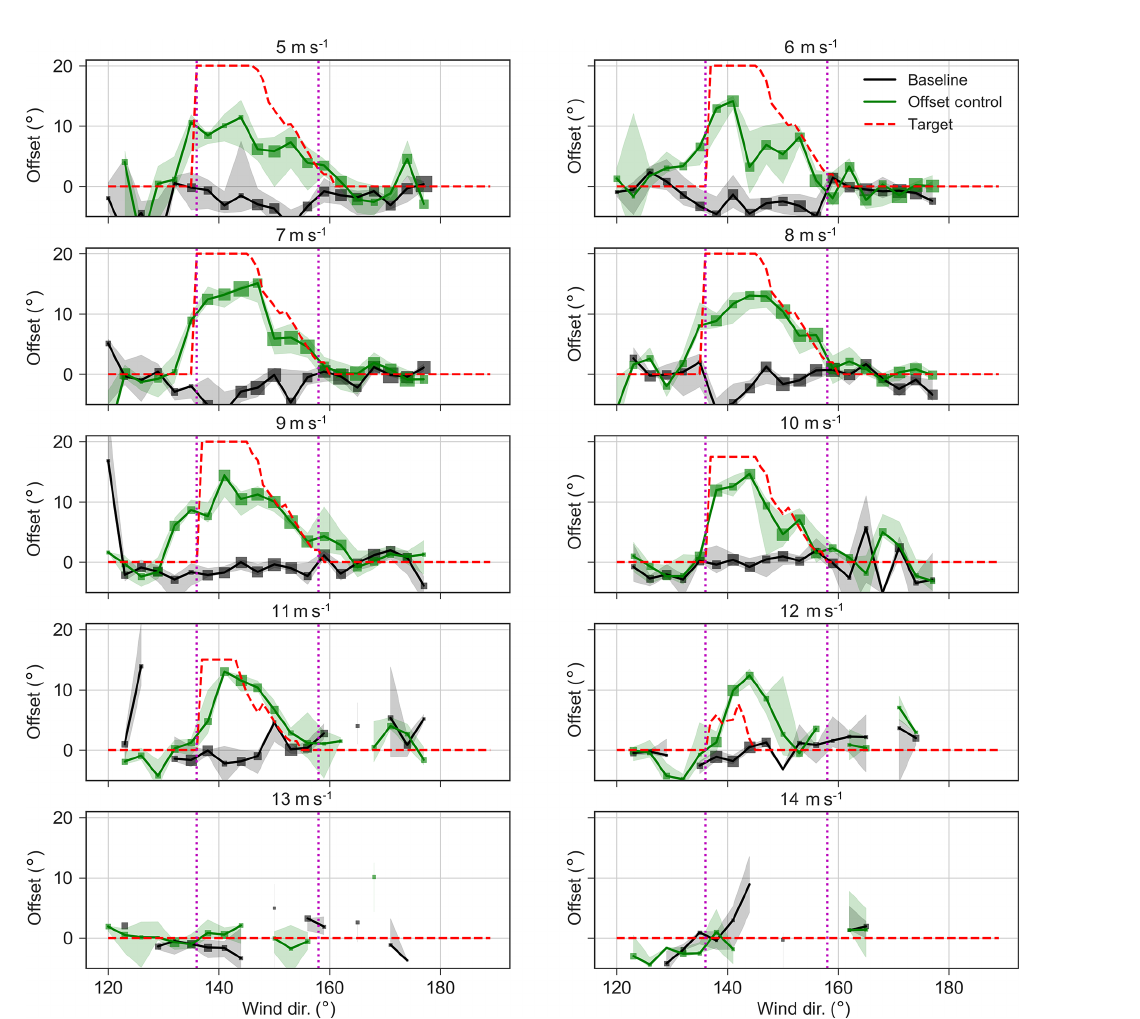
Figure 8. Comparison of observed yaw offset (green line) versus target (dashed red line) segregated by wind speeds. Note that the achieved offset is computed as the difference between the sodar-measured wind direction and the turbine nacelle heading. Points indicate median offset, with box size indicating the number of points in a bin and bands indicating the 95% confidence interval of the